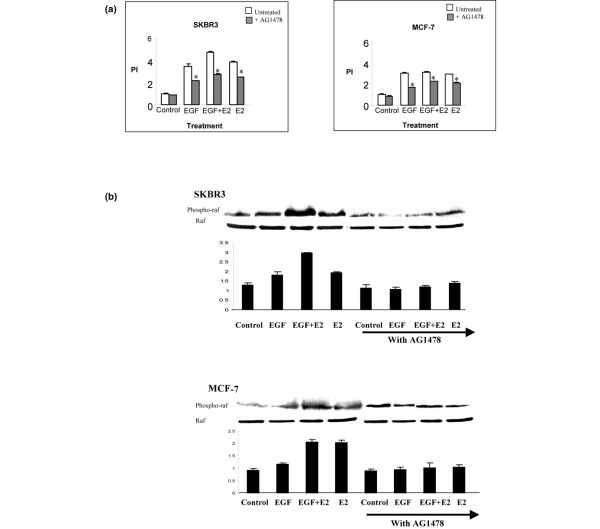
17β-estradiol and EGF induced cell proliferation and raf phosphorylation is mediated through EGFR. (a) SKBR3 and MCF-7 breast cancer cells were pretreated with or without the EGFR antagonist AG1478 (150 nmol/l) 1 hour before treatment with EGF (10 ng/ml) and 17β-oestradiol (10-8 mol/l) alone and in combination for 24 hours. Cell proliferation assays were carried out using MTT thiozolyl blue. Proliferative index of the control group is standardized to 1. The results shown are expressed as mean ± standard error (n = 9). Statistical analysis was performed using Mann-Whitney U test (*P < 0.02 versus without AG1478). (b) Western blot analysis of phospho-Raf and total Raf in SKBR3 and MCF-7 breast cancer cells pretreated with or without the EGFR antagonist AG1478 (150 nmol/l) for 1 hour before 10 minutes of incubation with EGF (10 ng/ml) and 17β-oestradiol (10-8 mol/l) alone and in combination. Results are representative of those obtained in three separate experiments. E2, 17β-oestradiol; EGFR, epidermal growth factor receptor; PI, proliferative index.